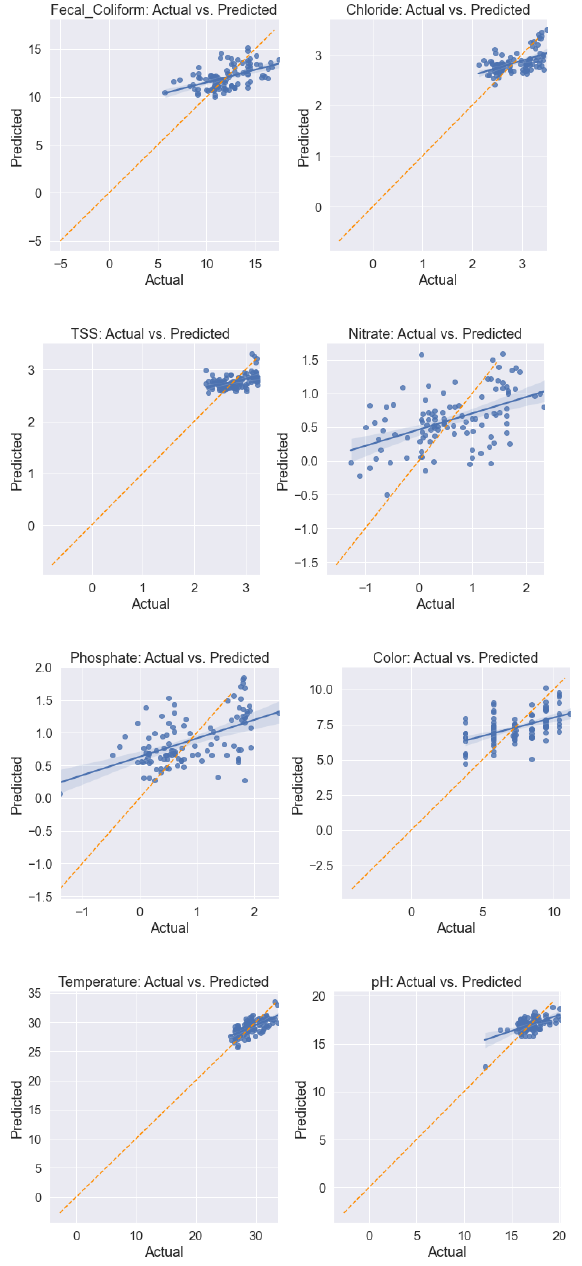
Appendix A . From upper-left to lower-right: BOD, DO, Fecal coliform, Chloride, TSS, Nitrate, Phosphate, Color, Temperature, pH: Shows the actual vs. predicted values of model in a